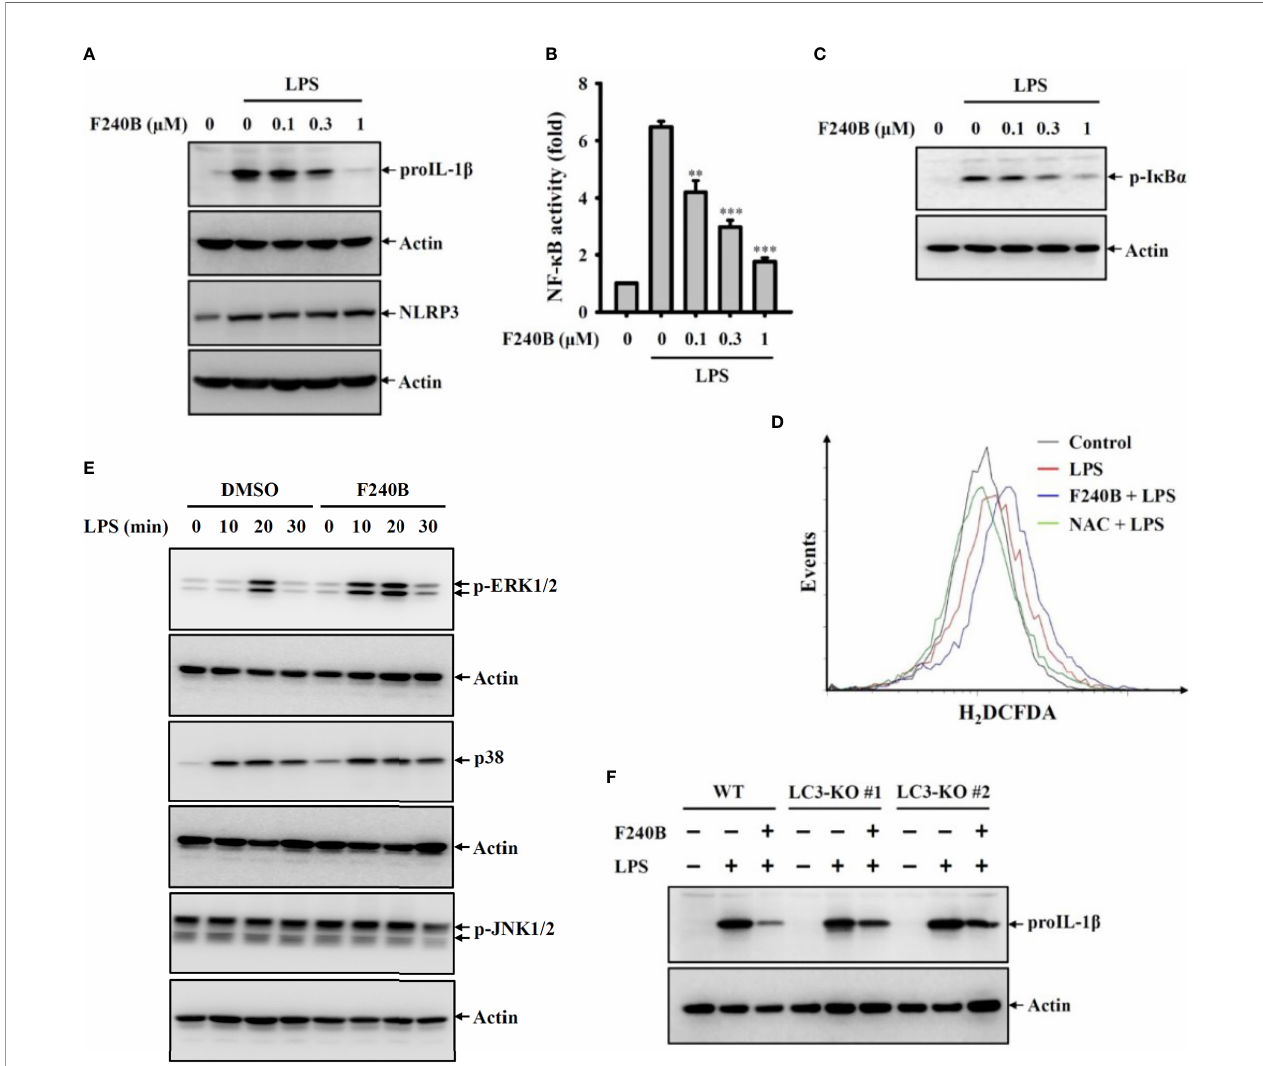
FIGURE 5 | Activation of autophagy by F240B inhibits NF-kB activation and proIL-1b expression. (A) J774A.1 macrophages were incubated with F240B for 0.5 h followed by incubated with 1 m g/ml LPS for 6 h. The levels of proIL-1b and NLRP3 in the cell lysates were measured by Western blotting. (B) J-Blue cells were incubated with F240B for 0.5 h followed by incubated with 1 m g/ml LPS for 24 h. The NF-kB transcriptional activity was measured by NF-kB reporter assay. (C, D) J774A.1 macrophages were incubated with F240B (1 m M for ROS assay) for 0.5 h followed by incubated with 1 m g/ml LPS for 10 min. The phosphorylation levels of IkBa in the cell lysates were measured by Western blotting (C) , and the intracellular ROS production was analysed by H2DCFDA staining (D) . (E) J774A.1 macrophages were incubated with 1 m M F240B for 0.5 h followed by incubated with 1 m g/ml LPS for 10-30 min. The phosphorylation levels of ERK1/2, JNK1/2 and p38 in the cell lysates were measured by Western blotting. (F) Will-type or LC3-knockout J774A.1 macrophages were incubated with1 m M F240B for 0.5 h followed by incubated with 1 m g/ml LPS for 6 h. The levels of proIL-1b in the cell lysates were measured by Western blotting. ** and *** indicate a signi fi cant difference at the level of p < 0.01 and p < 0.001, respectively compared to